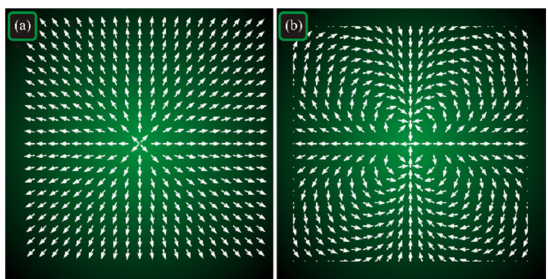
Figure 1. Intensity distributions of a Gaussian beam and the electric field strength vectors, when the beam has cylindrical polarization (1) with n = 1 ( a ) and n = 3 ( b